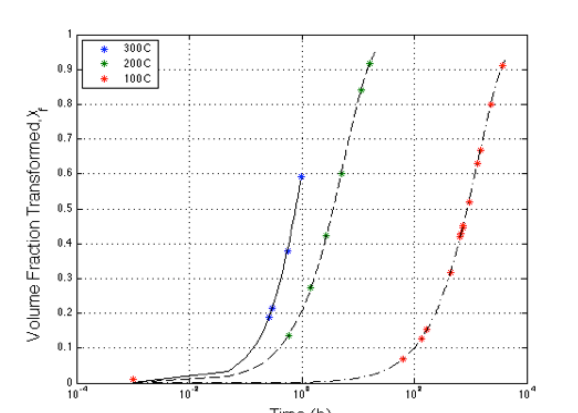
Figure 2. Volume fraction of cellular precipitation vs. aging time of the alloy aged at 100, 200, and 300 o C. [ 15